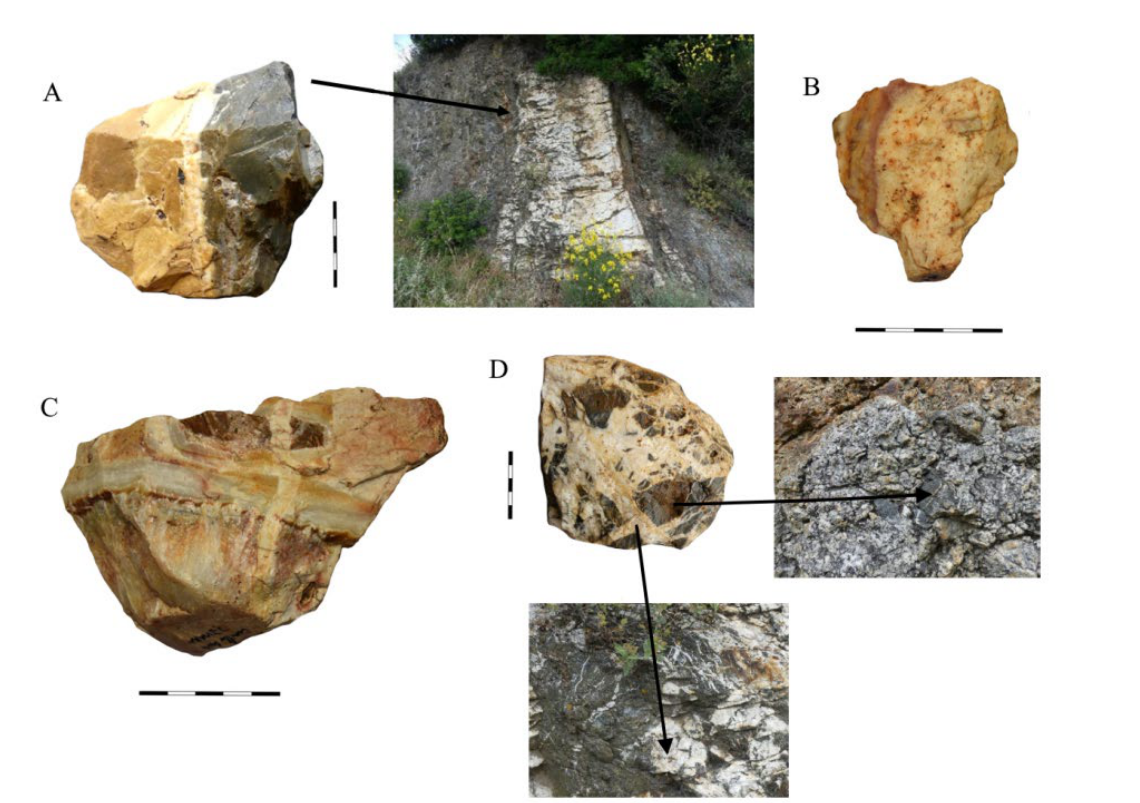
Figure 4. Examples of brecciated quartzites. A: Flake from Camillo and quartzite in primary position (Vailhan, Hérault). B and C: flakes of brecciated quartzite from Camillo. D: geological sample from the Fv terrace of Camillo and quartzite in primary position (Vailhan, Hérault). Scale bar: 5